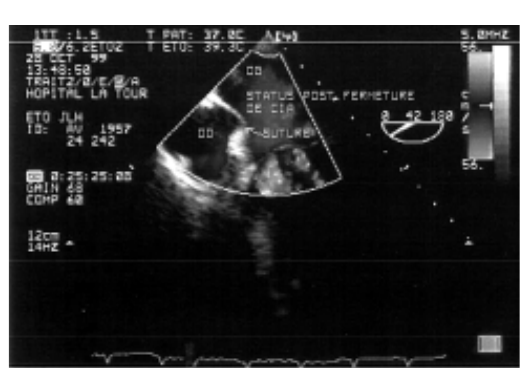
atrioseptorrafiaFig. 4 – Intra-operative transesophageal echocardiography demonstrating the right-left arterial shunt (in blue) by foramen ovale, before starting cardiopulmonary bypass in patient Nº 22 of this series